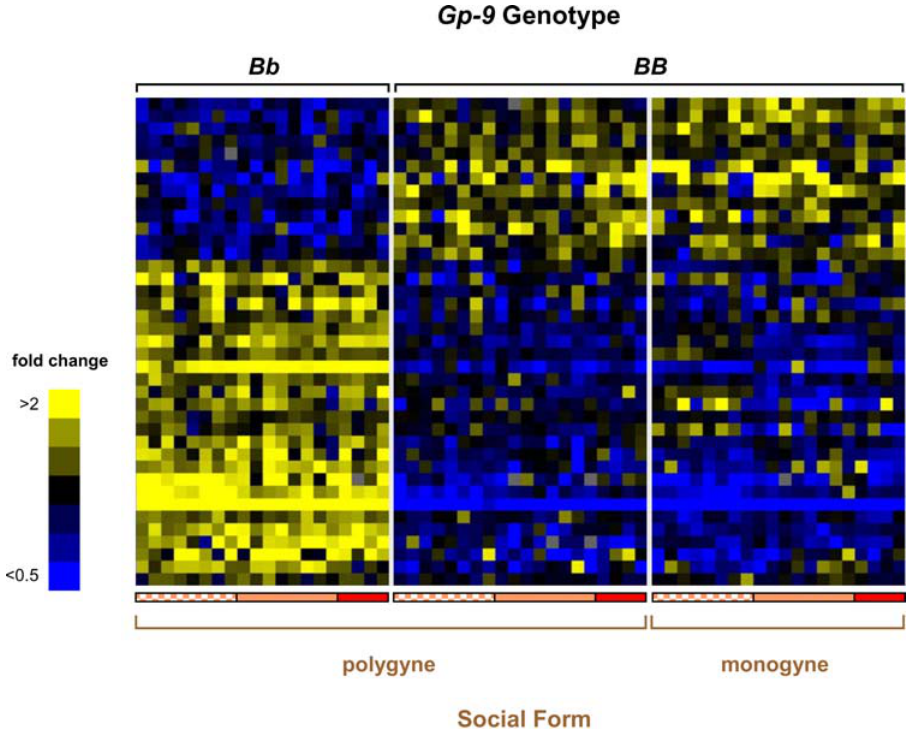
Figure 1. Expression profiles between S.invicta adult workers with the BB and Bb genotypes of Gp-9 . Expression profiles for 39 differentially expressed genes are depicted (ANOVA, 10% false discovery rate [FDR]). Each row represents data for one gene, and each column represents data for a pool of 7–10 nestmates with the same Gp-9 genotype sampled from each of twenty colonies of each social form. Colonies were collected from Georgia (2004, checkered peach bar; 2006, solid peach bar) and Louisiana (2006, solid red bar), USA (data from each polygyne colony are presented in the identical order for the alternate genotype groupings). Expression levels for each gene are depicted relative to the average level across all experimental samples (blue, low levels; yellow, high levels). Genes are arranged by hierarchical clustering. See Text S1 and Table S1 for confirmation of selected gene expression results with quantitative RT-PCR (qRT-PCR).